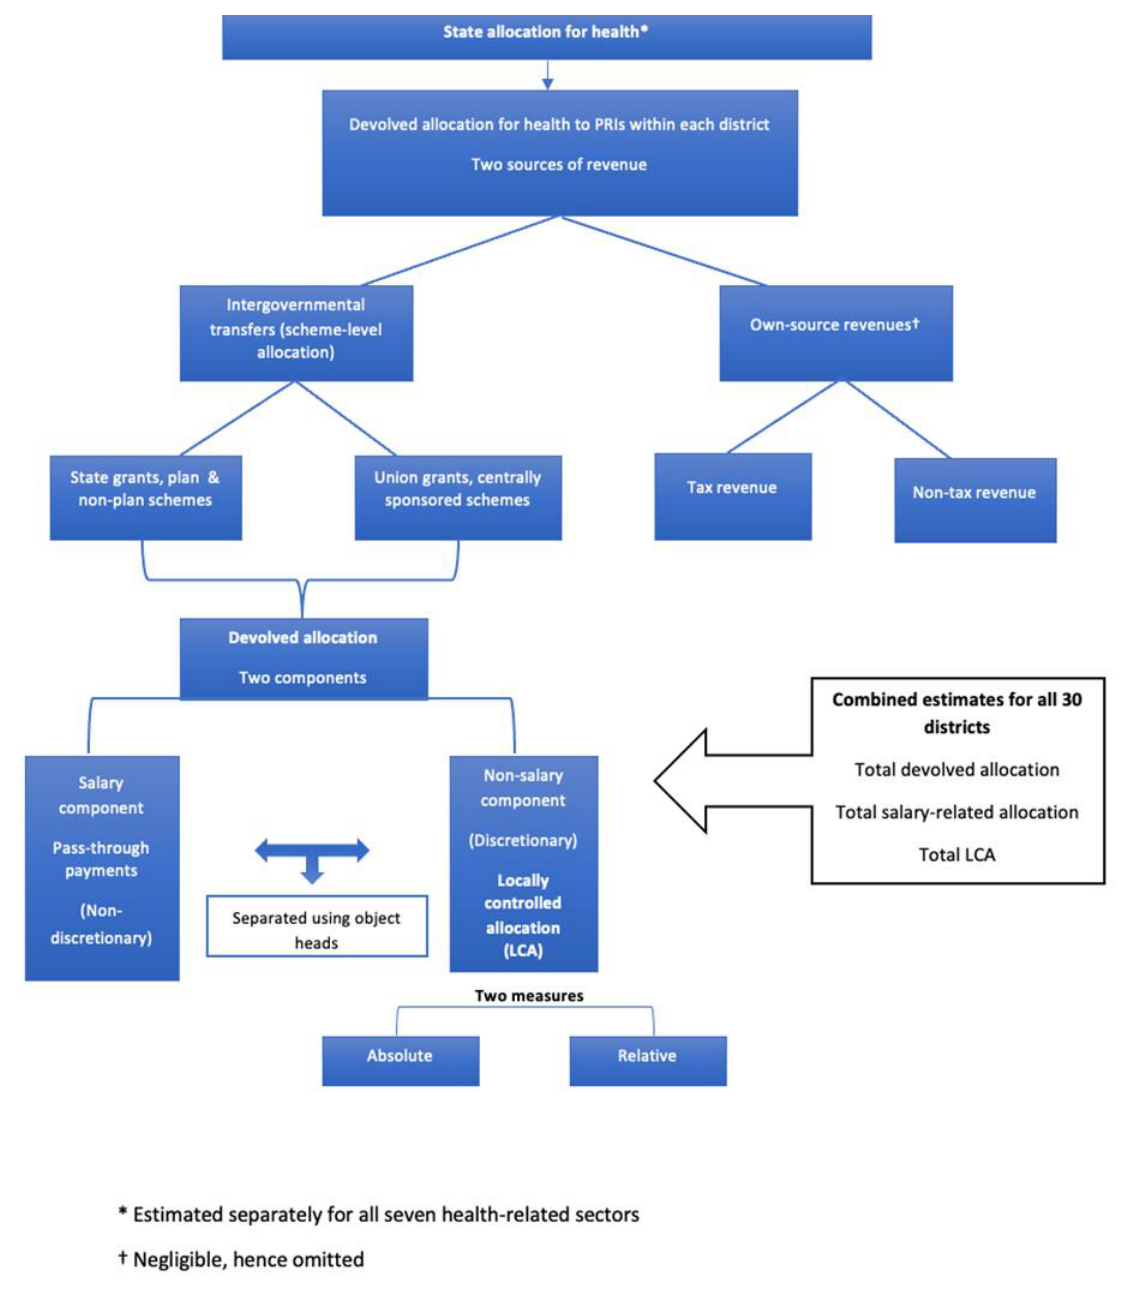
Figure 2: Measurement of fiscal